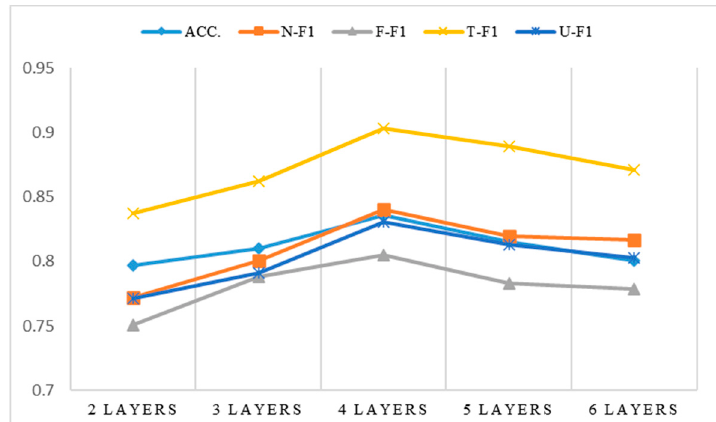
Figure 8. The effects of different classifier structures on the results.